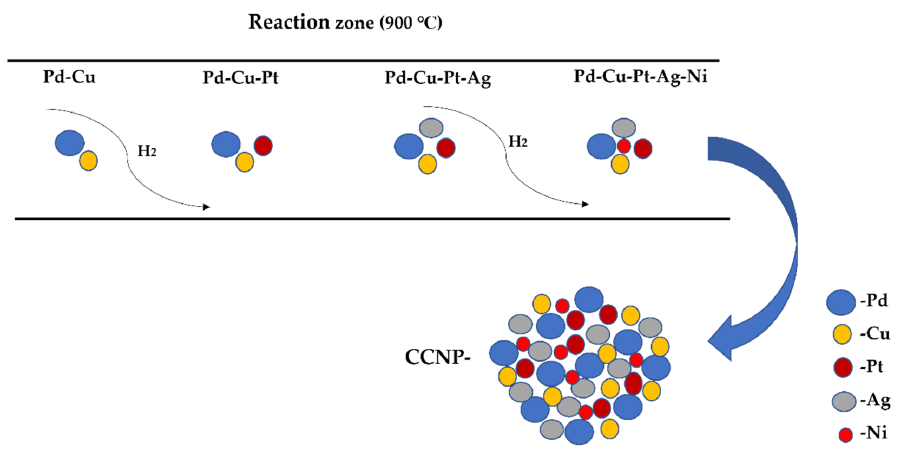
Figure 12. Proposed mechanism for the formation of CCNPs.